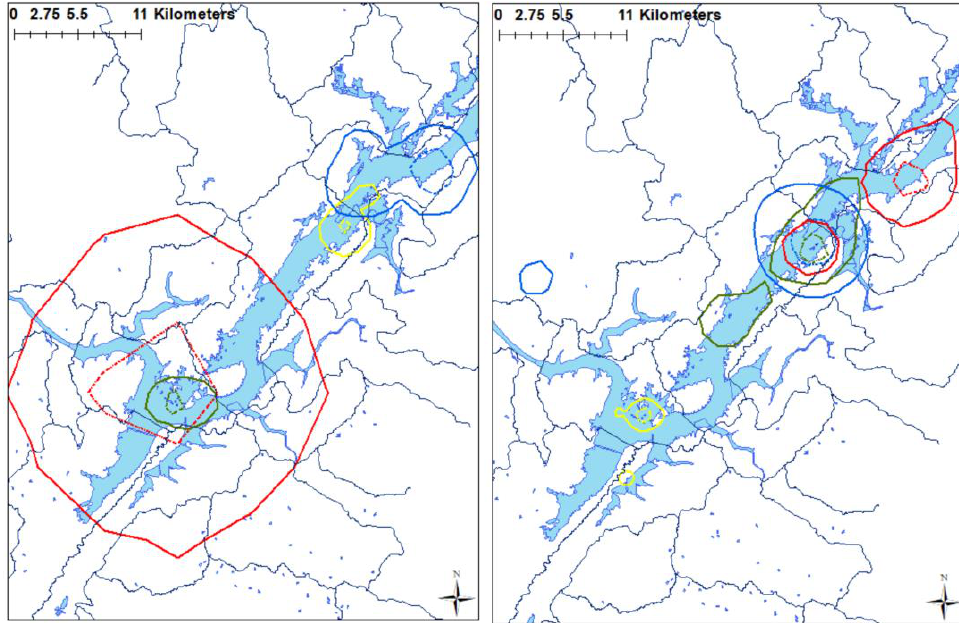
Figure 3. Home range and core use areas of for male Double-crested Cormorants at breeding colonies on the left ( n = 4) and females on the right ( n = 4) for the complete period of study March–August 2017. Different color lines differentiate individual birds and line types differentiate 95% (solid line) or 50% (dotted line) home range.